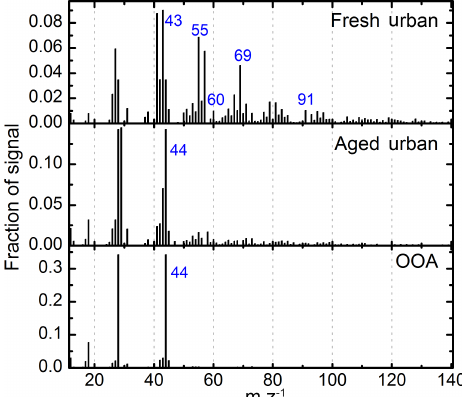
Figure 3. Mass spectra in fraction of signal of PMF factors, fresh urban, aged urban and